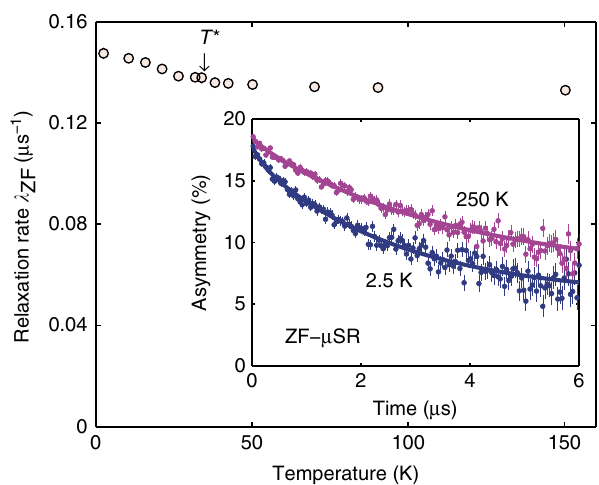
Fig. 2 ZF- μ SR time spectra and relaxation rates. The zero- fi eld relaxation rate λ ZF is small and practically constant with temperature, with only a tiny increase below T * . Inset: representative ZF- μ SR spectra at